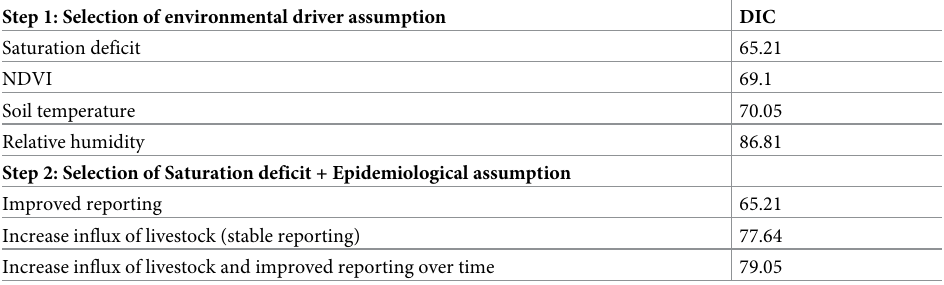
Table 3. Model comparison using DIC.